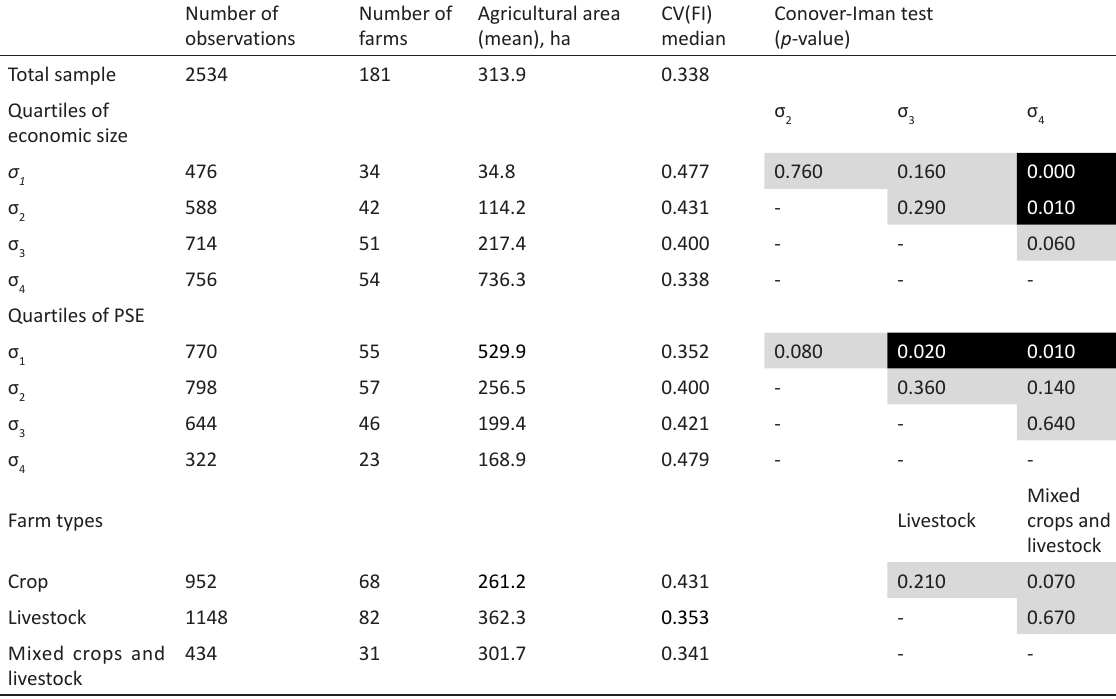
Table 2. Median of the CV(FI), results of the Conover-Iman test for equality of median values of CV(FI) in different economic size and PSE level quartiles ( restricted sample without negative MI observations)